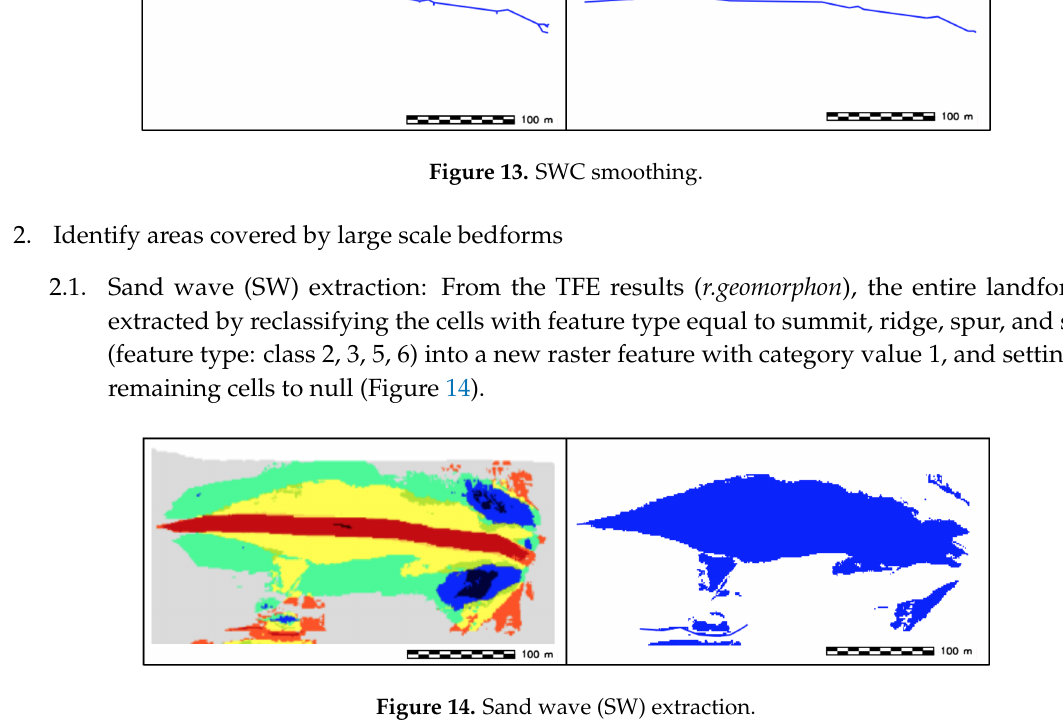
Figure 14. Sand wave (SW)